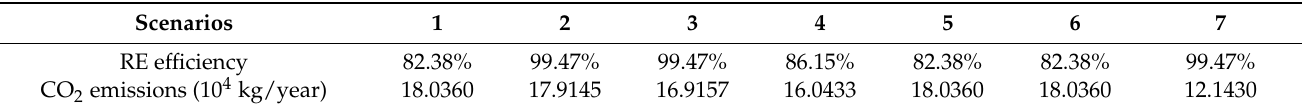
Table 5. RE utilization and CO 2